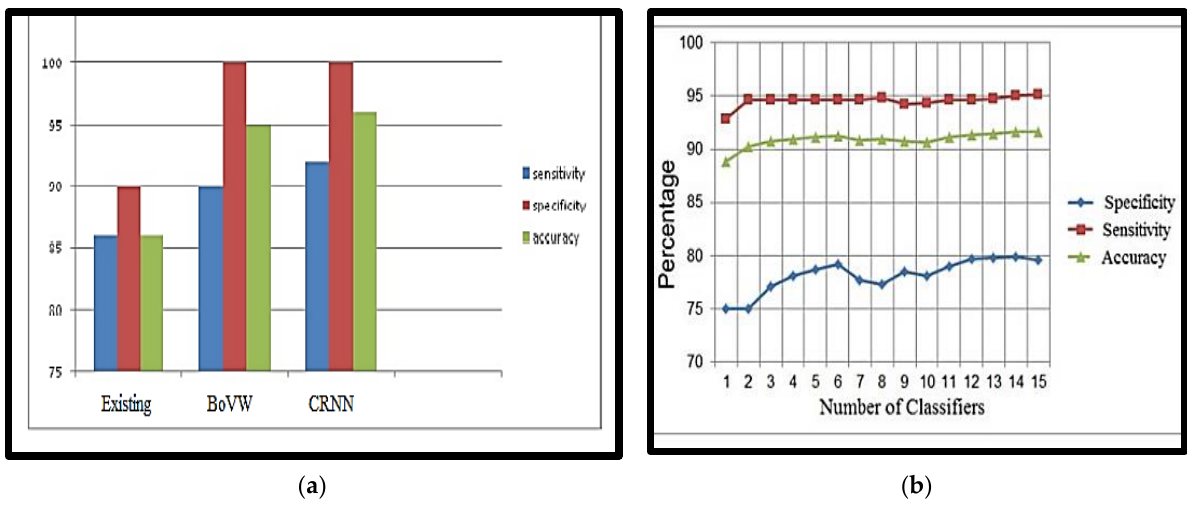
Figure 15. ( a ) Performance Measure of the classifier, ( b ) Performance Graph of the classifier.